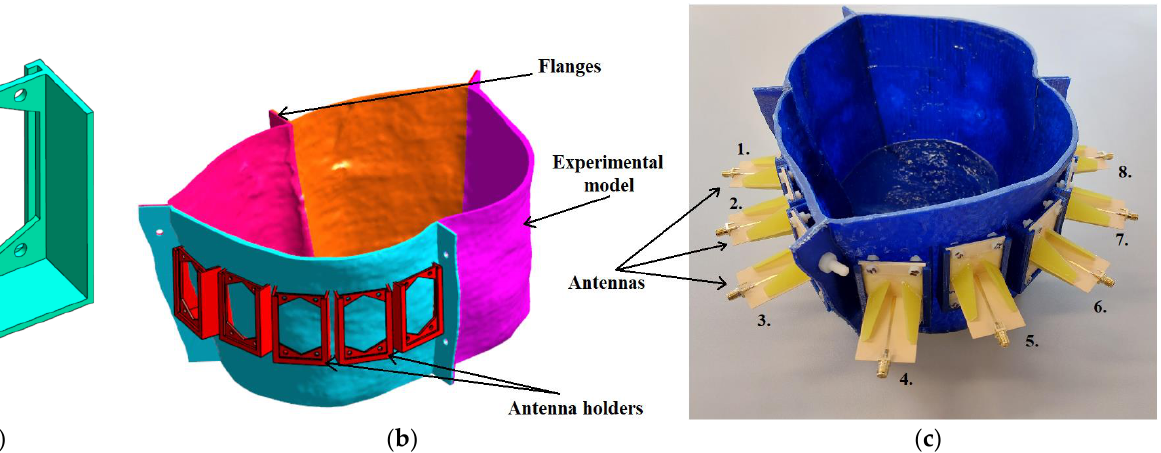
Figure 10. Experimental model: ( a ) Antenna holder; ( b ) Description of individual parts of the experimental model; ( c ) Assembled experimental model with placed antennas.